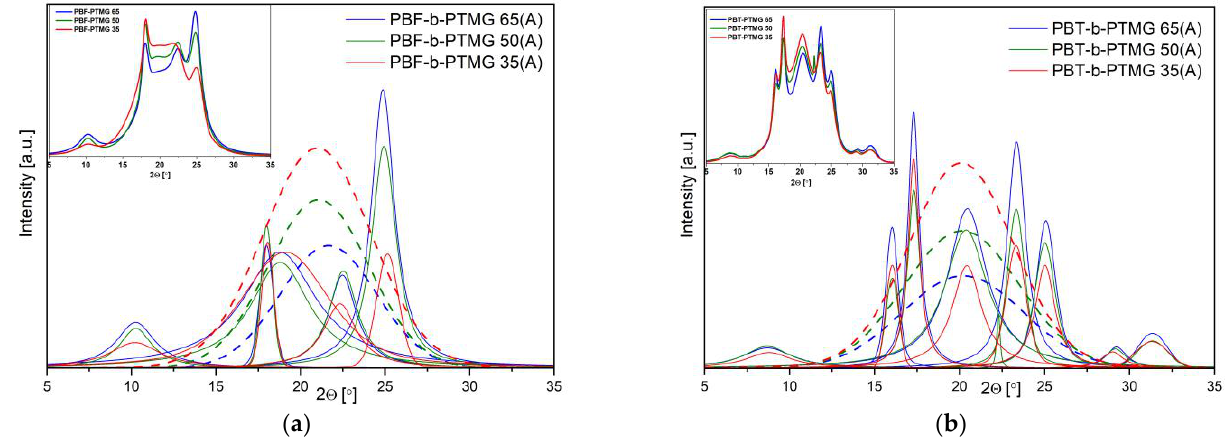
Figure 7. WAXS patterns of annealed injection molded samples after deconvolution to crystalline peaks and amorphous halo for ( a ) PBF-b-PTMG annealed at 70 °C and ( b ) PBT-b-PTMG annealed at 140 °C (the original data presented as inserts). The amorphous halo peaks marked in dash line.